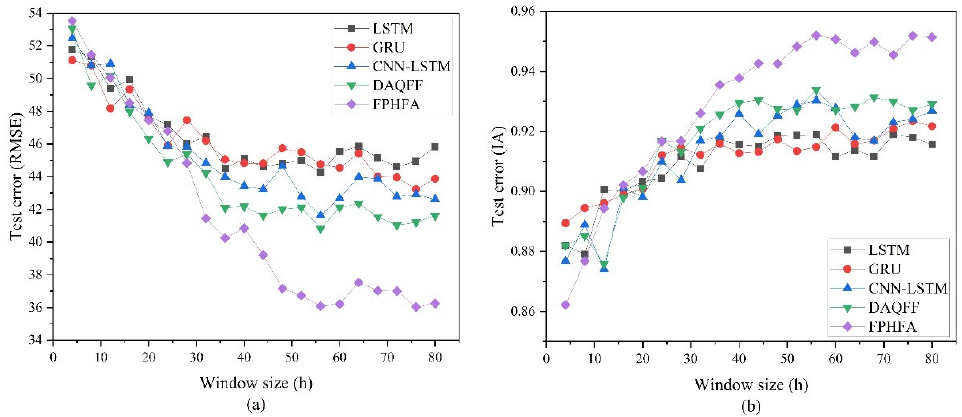
Figure 7. Prediction step is 12 h, batch size is 128, and number of epochs is 40. Effect of window size on RMSE and IA of the models in the Beijing dataset. ( a ) RMSE, ( b ) IA.